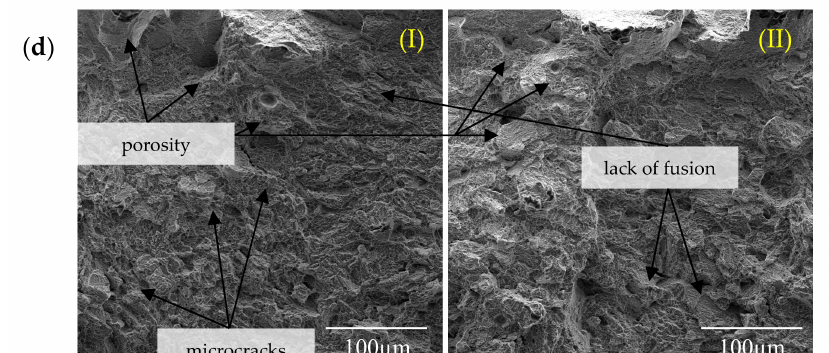
Figure 8. Strength parameters of samples heat treated at 750 ◦ C with di ff erent laser speeds and powers: ( a ) 130 W, ( b ) 170 W, ( c ) 210 W, and ( d ) fracture surface: (I) 130 W, 300 mm / s, ZX; (II) 130 W, 300 mm / s, XZ; 900 × ; Rm min and Re min for Ti6Al4V in accordance with ASTM F 1472.